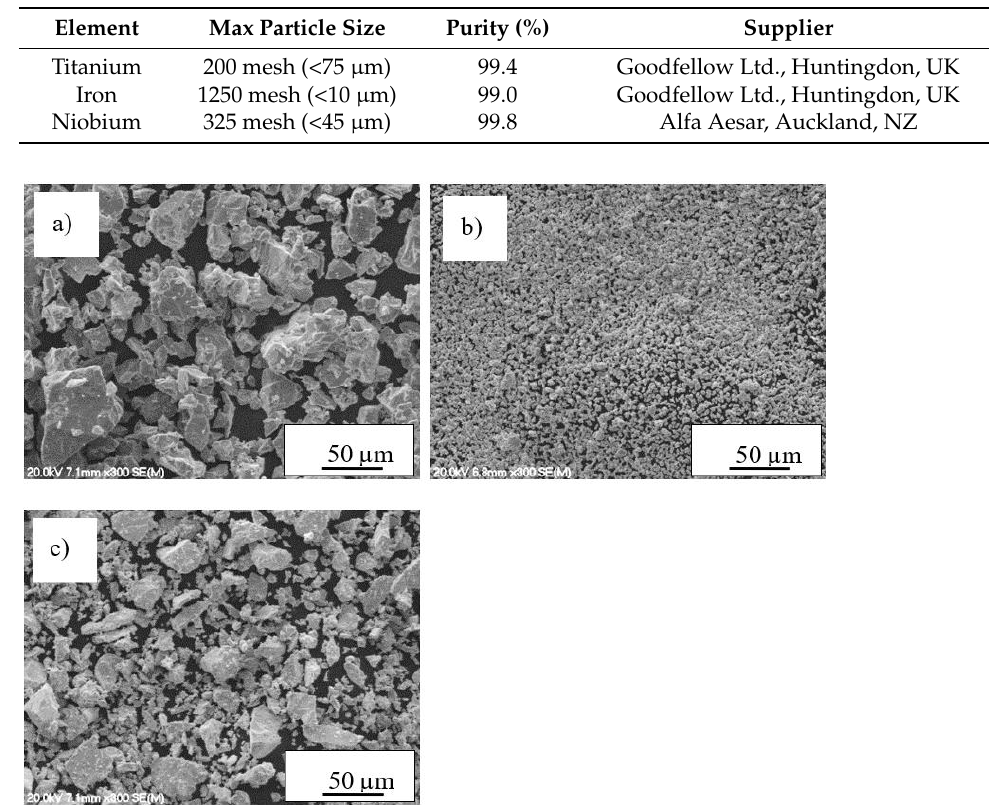
Figure 1. SEM micrographs of the elemental powders: ( a ) irregular Ti, ( b ) spherical Fe and ( c ) angu- lar